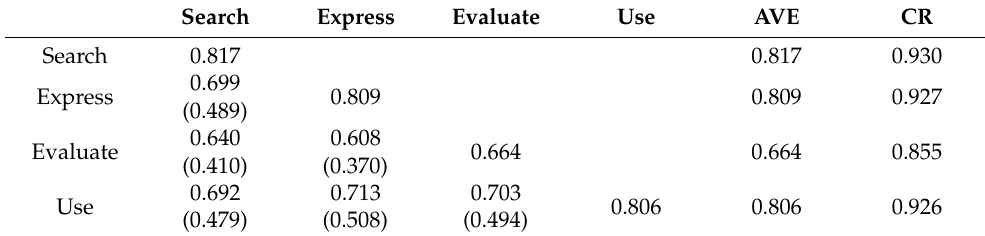
Table 3. Results of convergent and discriminant validity for the